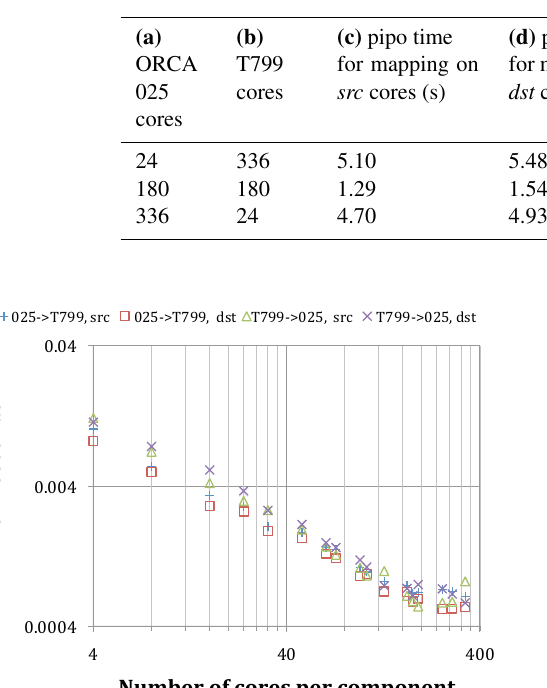
Table 1. Comparison of the ping-pong (pipo) time for the T799-ORCA025 toy model on Lenovo on 360 cores with both the relative core count/component and the mapping location varied. The time is in seconds for 1000 ping-pongs. Columns (a) and (b) define the core count used for each component of the toy model. Columns (c–f) are the pipo times for four different mapping approaches: (c) mapping always on the source cores, (d) mapping always on the destination cores, (e) mapping on the ORCA025 cores, and (f) mapping on the T799 cores.